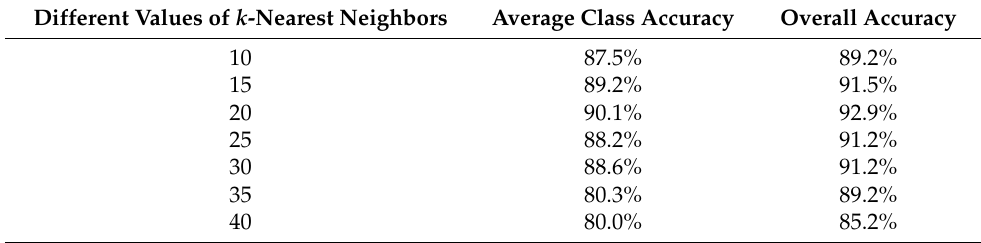
Table 2. Classification accuracy of our model using different k -nearest neighbors. Different Values of k -Nearest